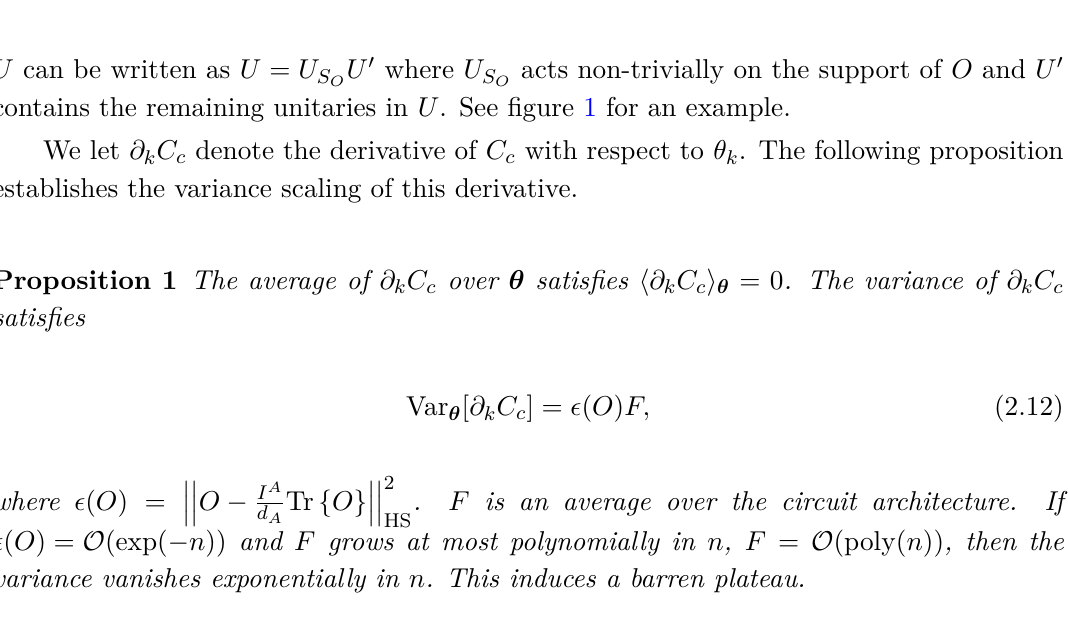
Figure 1 . A quantum circuit with a brick-layer architecture. The parameterized unitary U acts on an input state | ψ 0 i ; we perform a measurement on system A . The unitary U can be written as U = U S U 0 , where U S is the unitary which acts non-trivially on system S O such that A ⊆ S O . O O We define U 0 as the unitary composed of the remaining unitaries in the